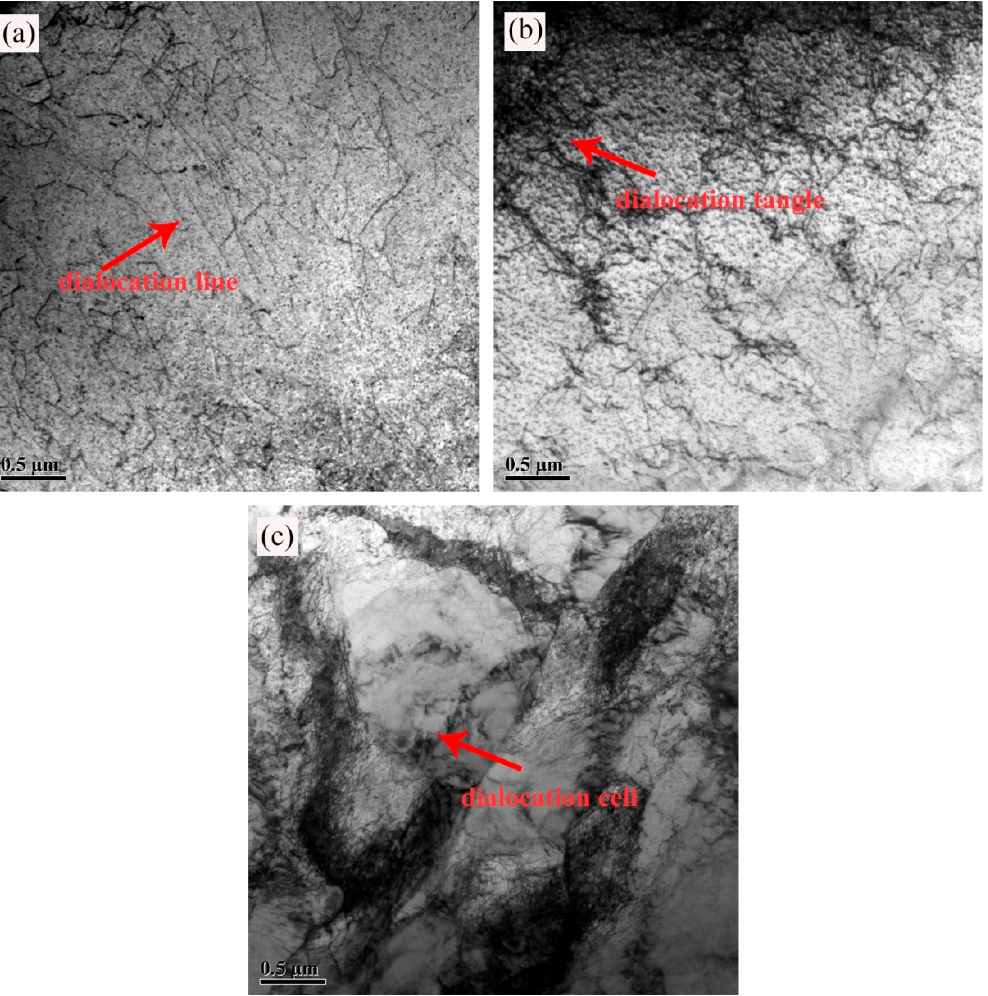
Figure 15. Microstructure of the base-material region of creep samples for different stresses: ( a ) 3-550-160; ( b ) 3-550-180; and ( c ) 3-550-220.